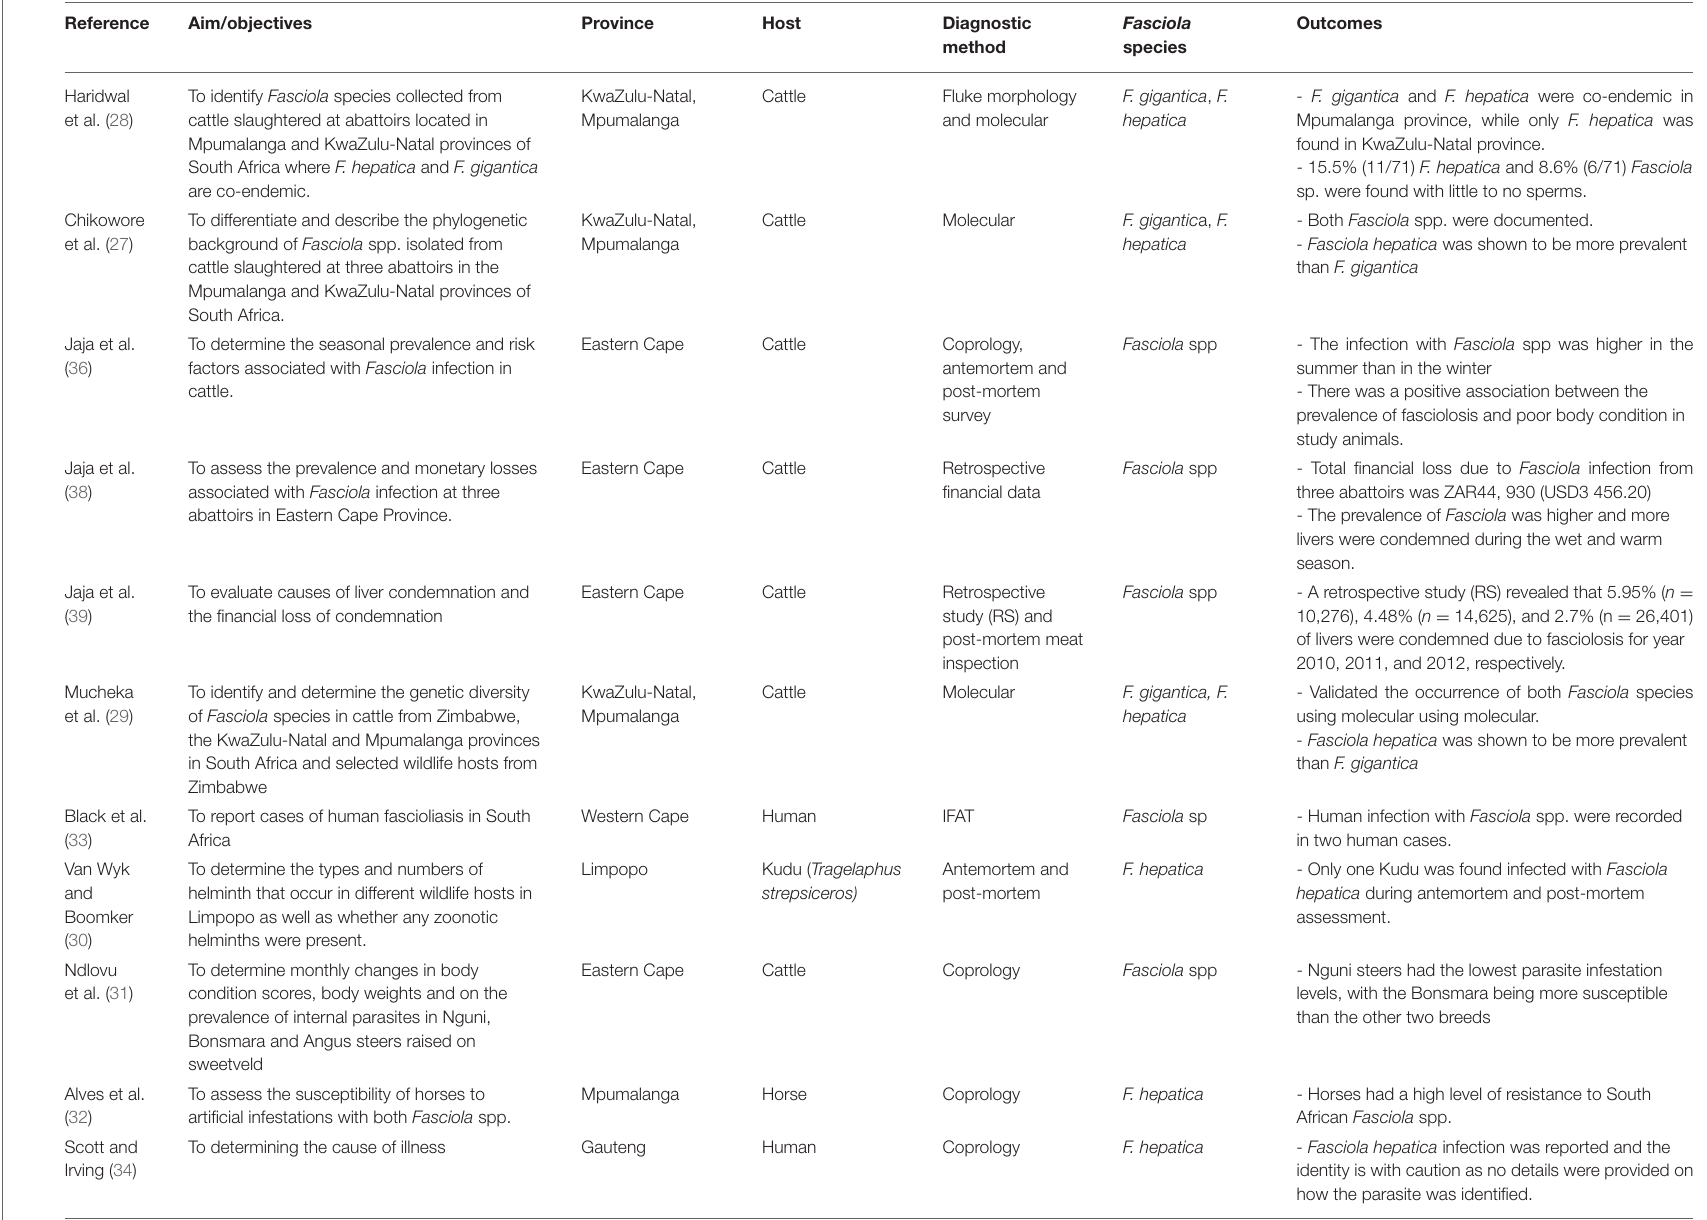
TABLE 1 | Summary of studies which reported Fasciola spp. infection in livestock, wildlife and humans in different provinces of South Africa (1960–2021).